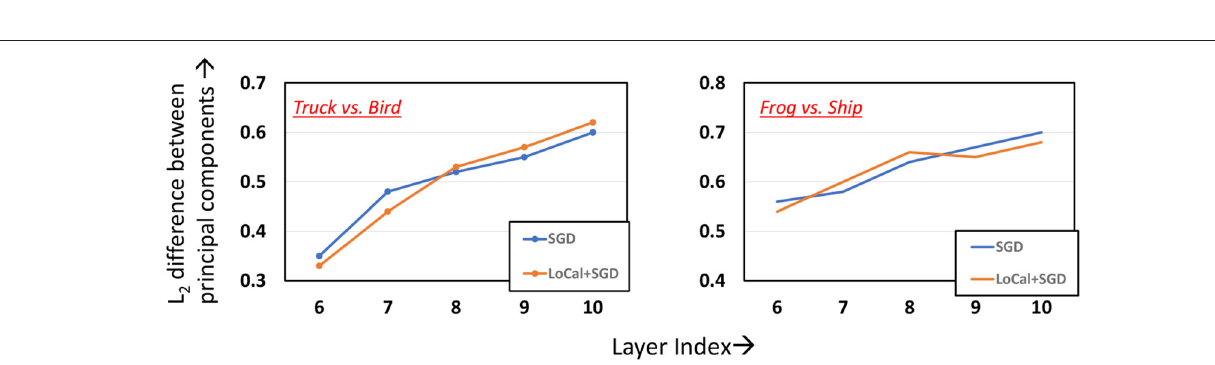
FIGURE 8 | Analyzing L 2 difference between the principal components across the